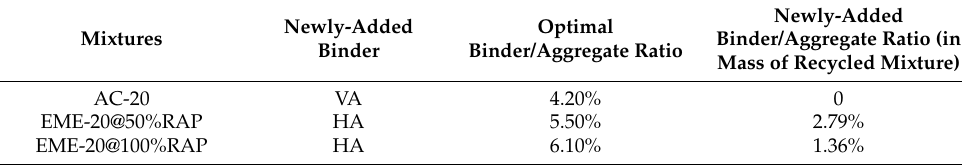
Table 7. Asphalt contents of the three mixtures.